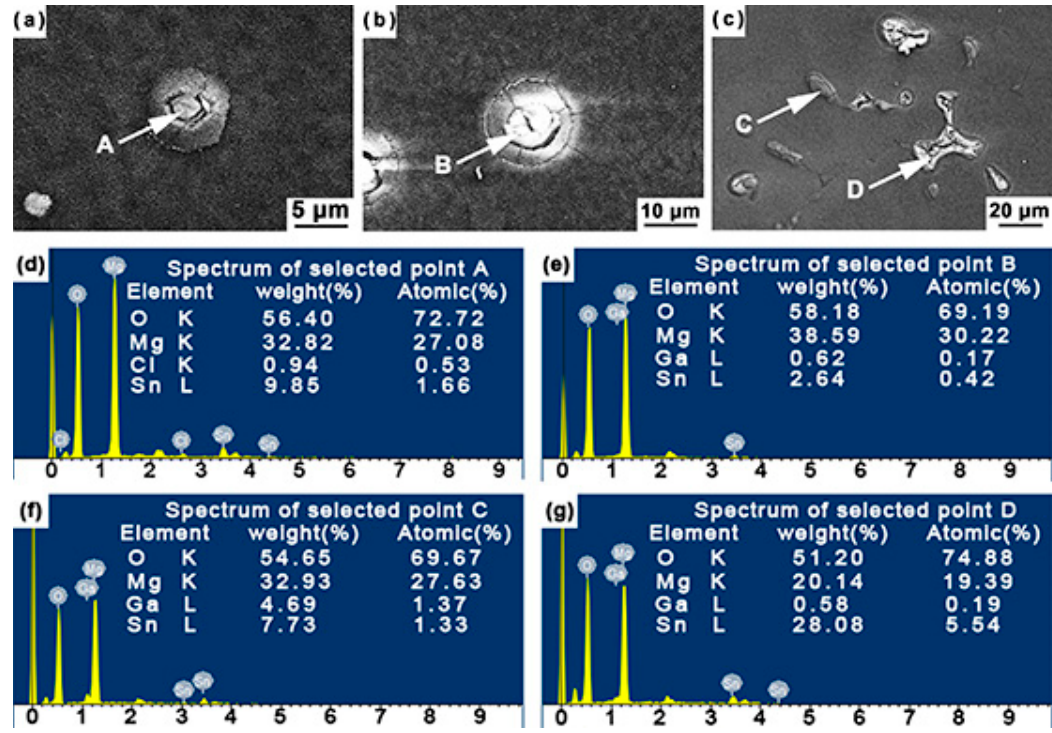
Figure 7. High magnification BSE micrographs showing the alloy surfaces after immersion in 3.5 wt % NaCl solution at 298 K for 6 h: ( a ) Mg–5Sn, ( b ) Mg–5Sn–0.5Ga, ( c ) Mg–5Sn–3Ga; ( d – g ) energy-dispersive X-ray spectroscopy (EDS) spectra of the points as indicated by the arrows in the BSE micrographs.